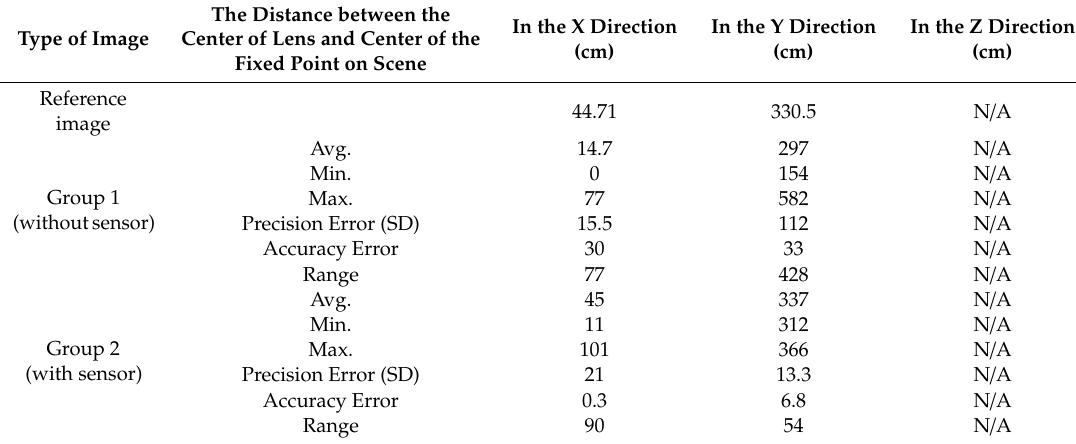
Comparison between accuracy and precision of the two approaches regarding linear